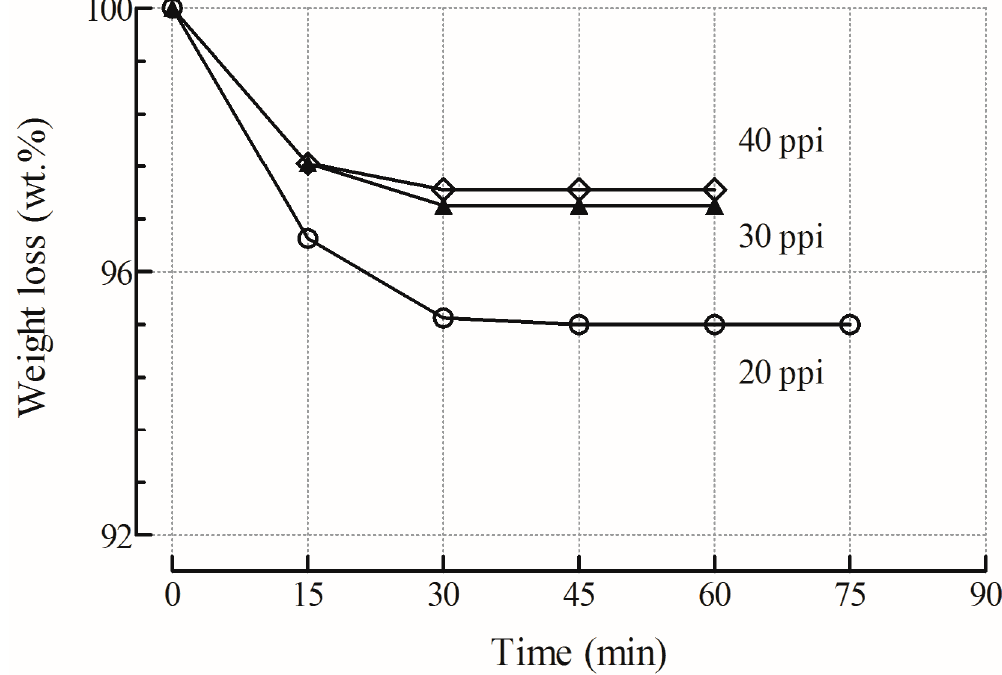
Figure 6. Weight loss as a function of time during the ultrasonic treatment of the coated